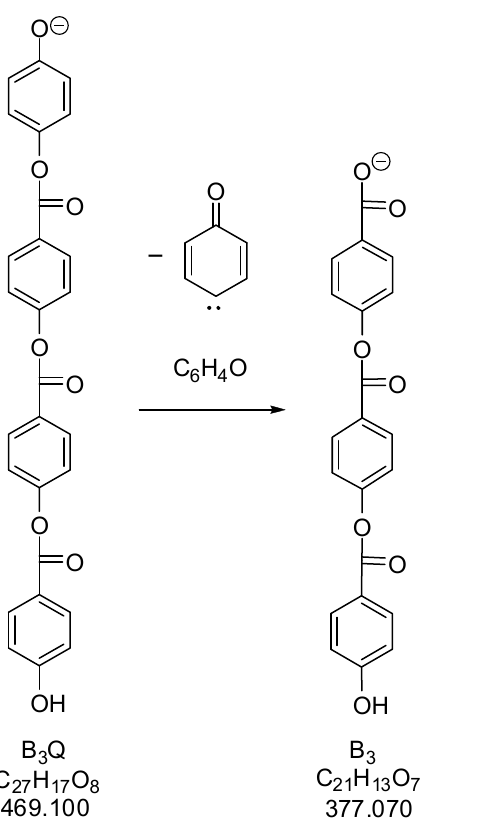
Scheme 5. Carbene-forming eliminations in